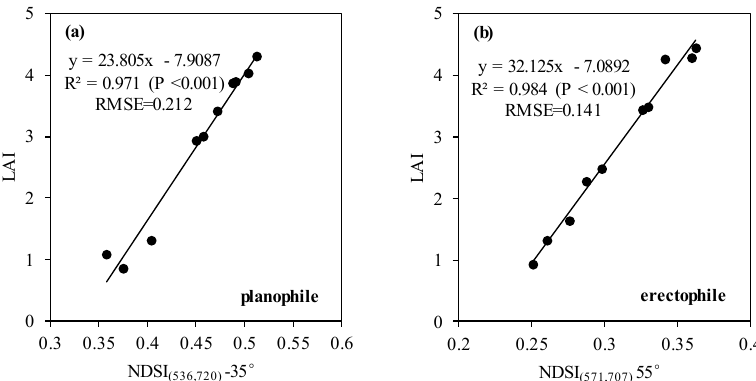
Figure 7. Optimal linear relationships between NDSI(x,y) and LAI for ( a ) the planophile and ( b ) erectophile varieties based on in-situ measurements.